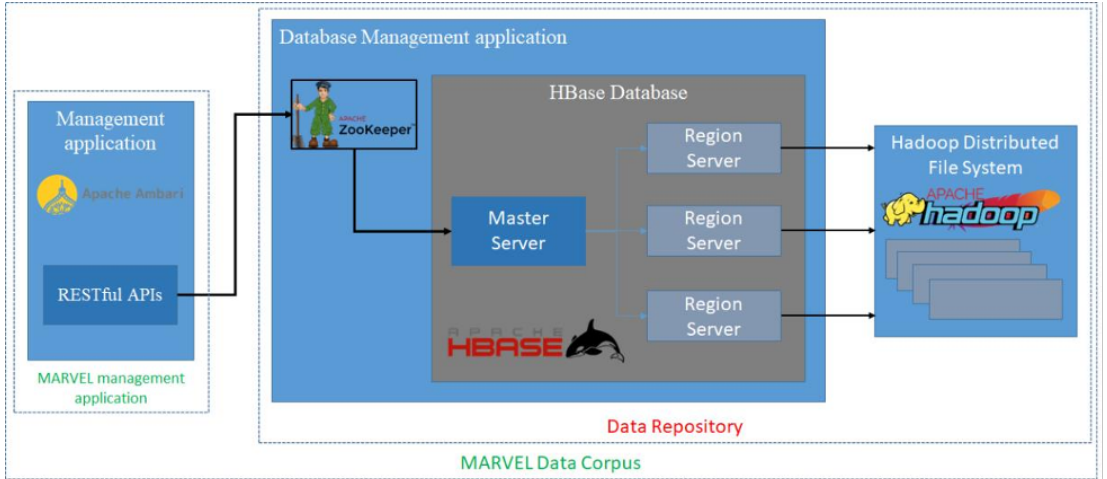
Figure 5. H2020 MARVEL project’s Data Corpus